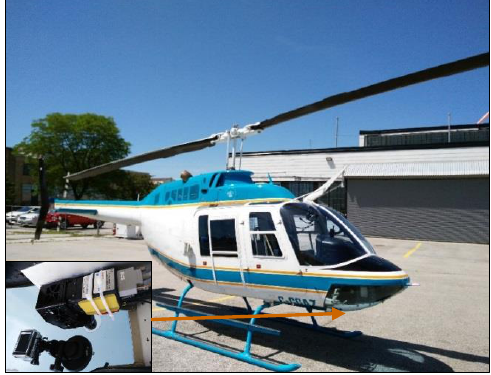
Figure 2. Hyperspectral sensor mounted on a helicopter.